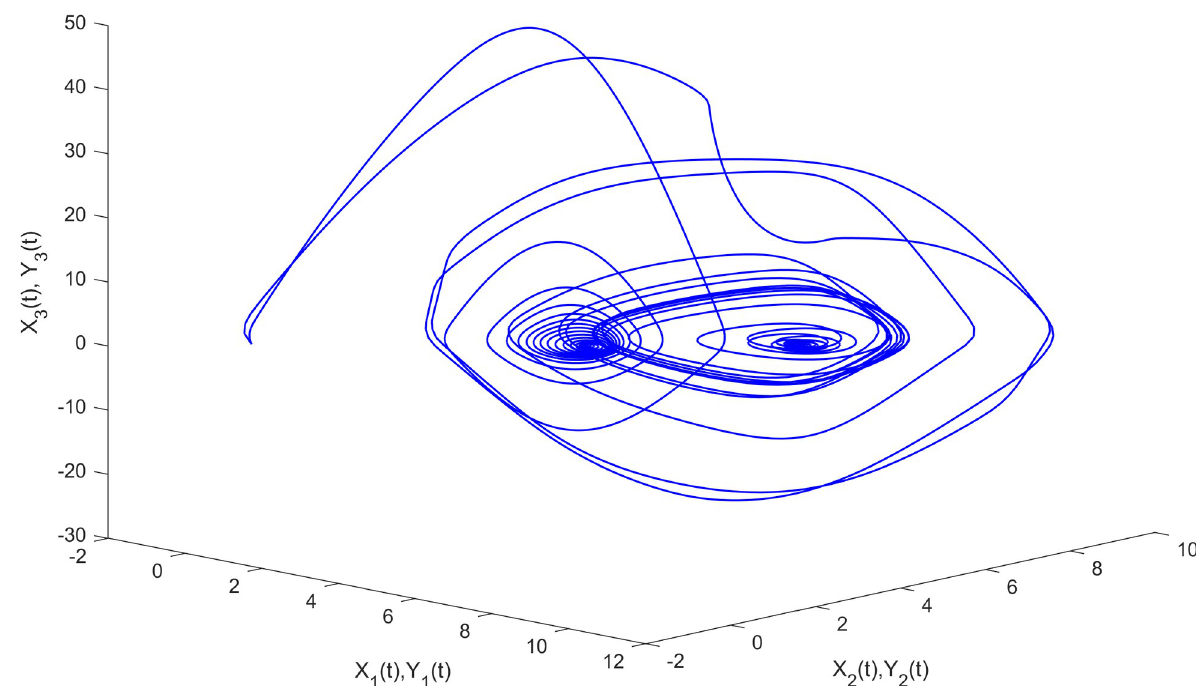
Fig 2. The chaotic attractor of multi-FONNSMD systems (24) and (25)—Phase portrait.